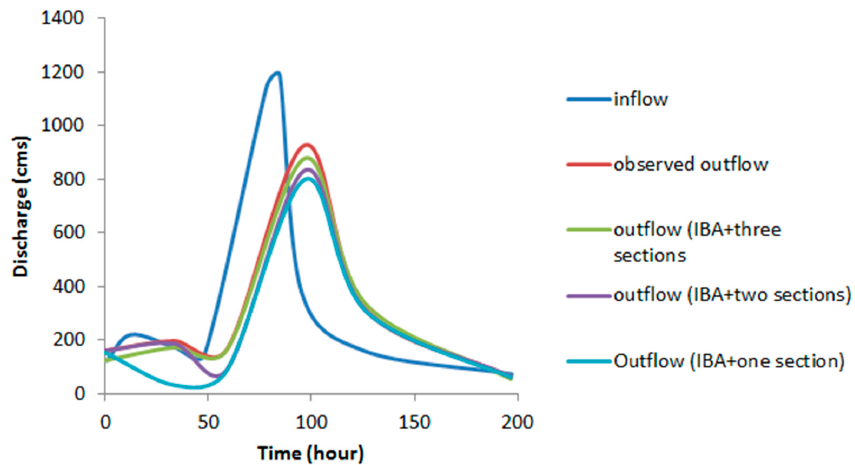
Figure 4. Simulated hydrograph for Karahan flood. Figure 4 . Simulated hydrograph for Karahan flood. Table 6. Inflow and outflow for Karahan